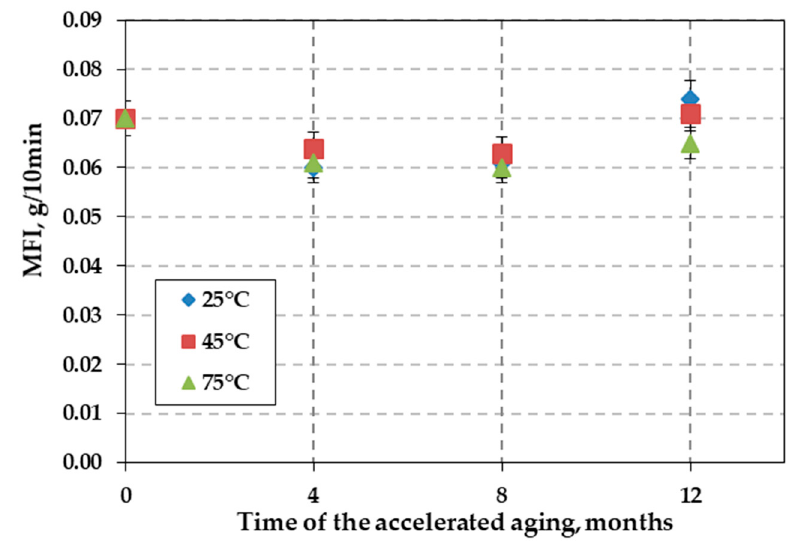
Figure 6. Variation in melt flow index (MFI) of the HDPE geogrid sample with time in leachate at three temperatures: 25 °C, 45 °C, and 75 °C. temperatures: 25 ◦ C, 45 ◦ C, and 75 ◦